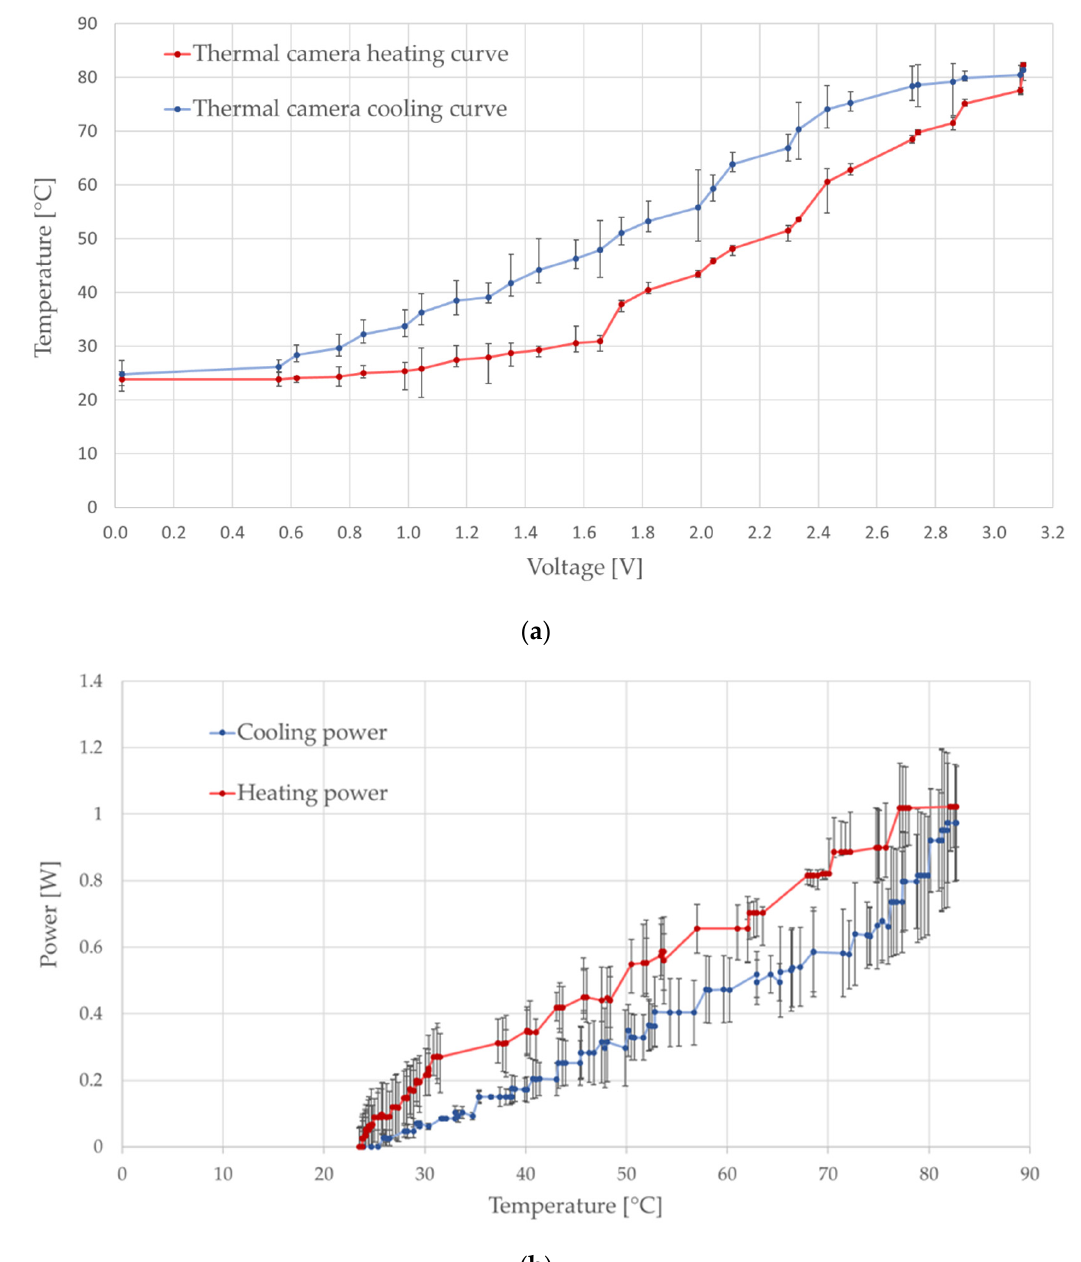
Figure 5. ( a ) System characterization for the thermal camera based in 0.1 V step changes; ( b ) Power consumption vs. temperature curve. The error bars show the standard deviation on each measurement point.